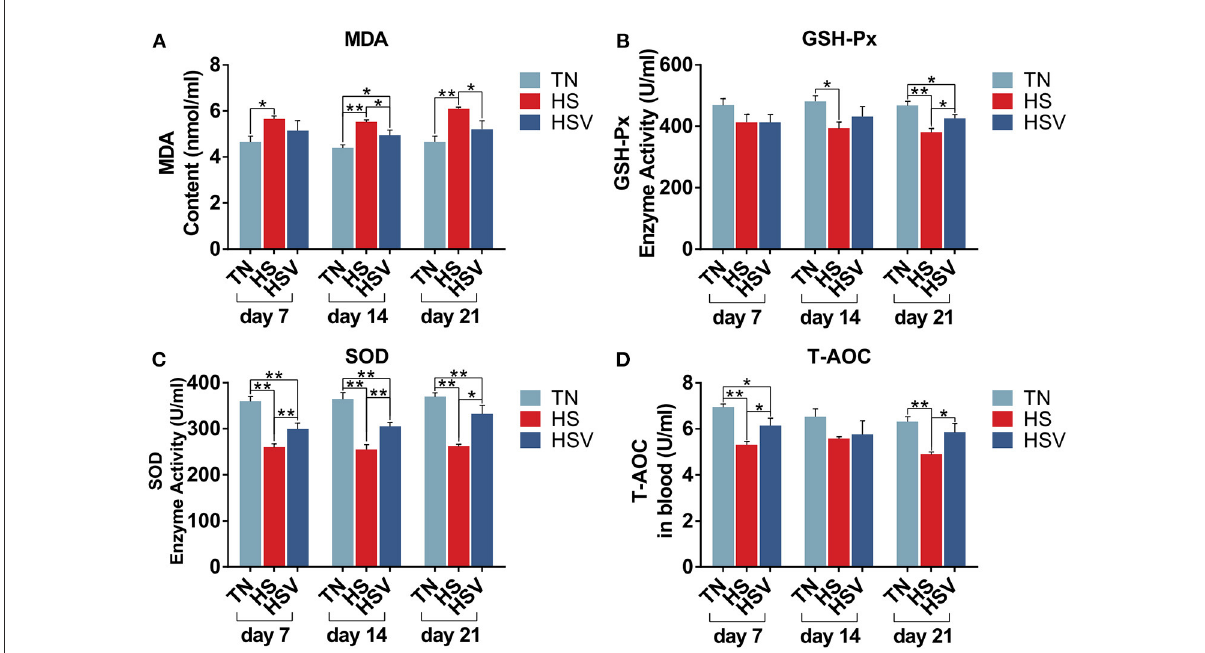
FIGURE3 Effects of vitamin C on liver redox status of chronically heat-stressed laying hens. (A) blood chemistry parameters of MDA; (B) blood chemistry parameters of GSH-Px; (C) blood chemistry parameters of SOD; and (D) blood chemistry parameters of T-AOC.